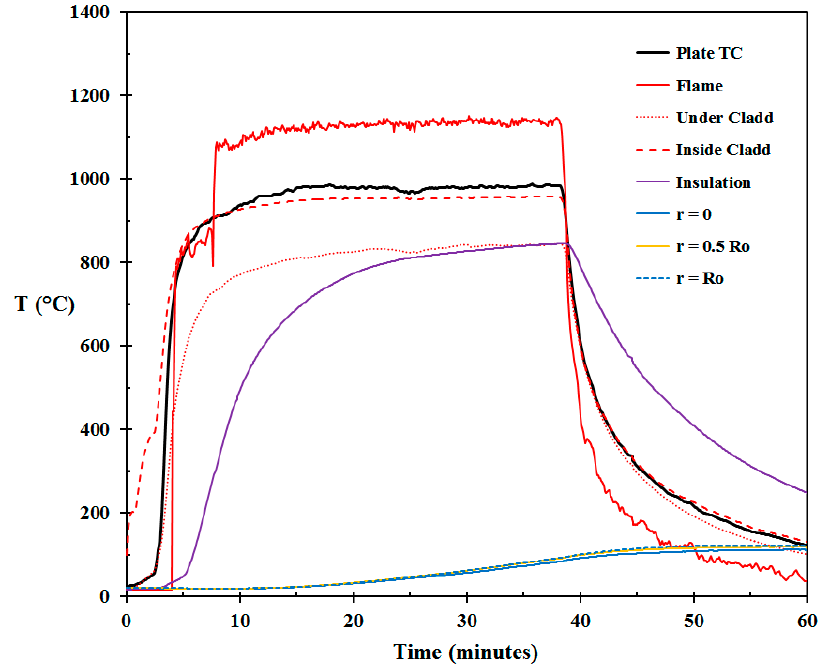
Figure 10. Temperatures recorded in Test 1 (Plate TC is the temperature of the plate thermometer, Flame is the temperature recorded in the flame zone, Under Cladd is the temperature recorded below the lower cladding, Inside Cladd is the temperature recorded inside the upper (exposed) cladding, Insulation is the temperature recorded in the center of the thermal insulation, r = 0, r = 0.5 Ro and r = Ro are the temperatures recorded in the exposed 16 mm steel plate at 0 cm, 8 cm and 15.5 cm radius, respectively).